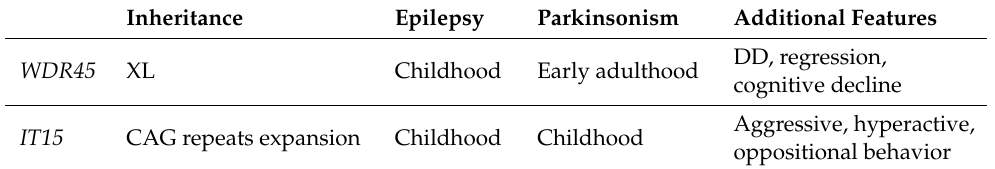
Table 3. Neurodegenerative disorders possibly presenting with epilepsy followed by